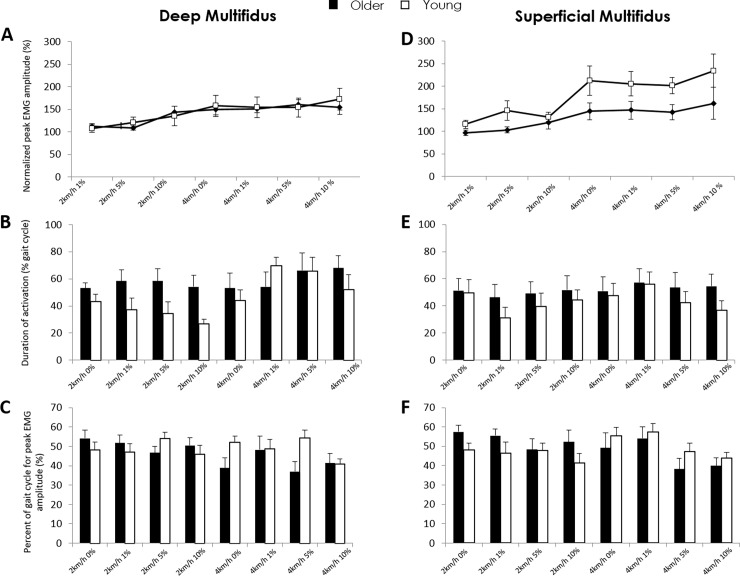
Intramuscular EMG amplitude (mean and SD) in young and older adults for deep (left) and superficial (right) multifidus during treadmill-walking under various speed-inclination conditions.A&D, Normalised (to 2km/h-0%) peak amplitude; B&E, Duration of activation as percent of the gait cycle; C&F, Percentage of the gait cycle where peak amplitude occurred.